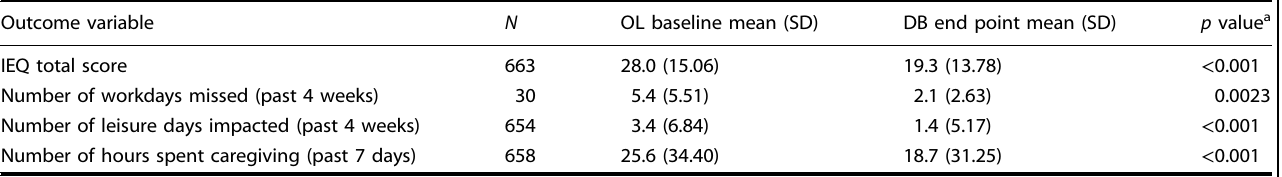
Table 4. Mirror image comparison (oral antipsychotic [prior to study entry] vs LAI [During the study] use) Outcome variable N OL baseline mean (SD) DB end point mean